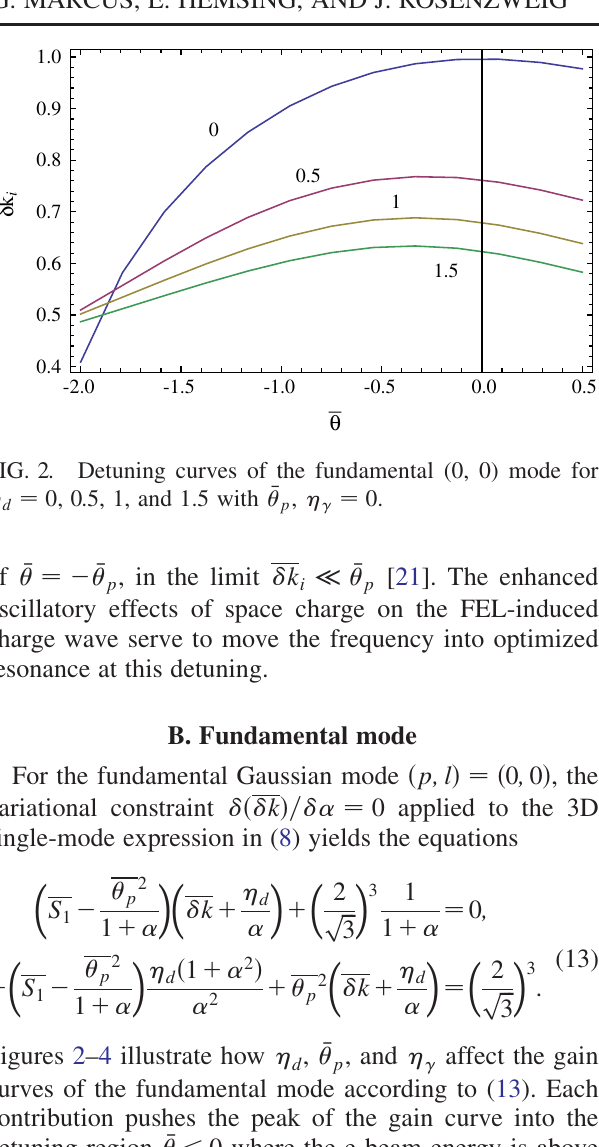
FIG. 3. Contribution of space charge on 3D system: 0.5, and 1 with (cid:5)